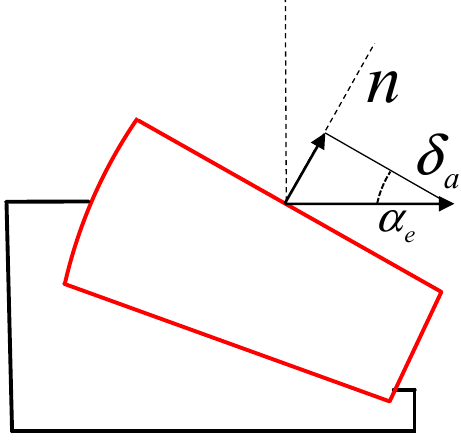
Figure 3. Displacement component.